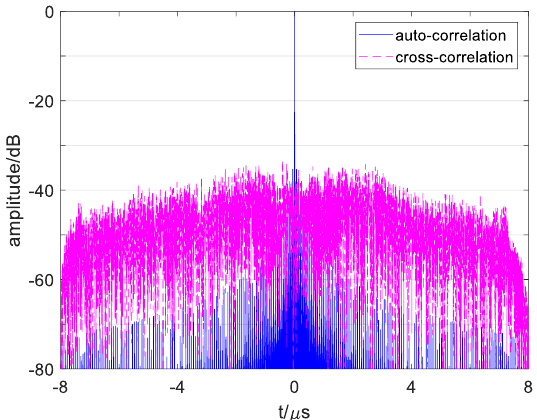
Sensors 2018 , 18 , x FOR PEER REVIEW 16 of 19 Figure 13. Correlation curve of designed OFDM chirp signals . Figure 13. CorrelationcurveofdesignedOFDMchirpsignals s 1 (cid:48) + s 2 (cid:48) and s 3 (cid:48) + s 4 (cid:48) during − 8 µ s < t < 8 µ s.